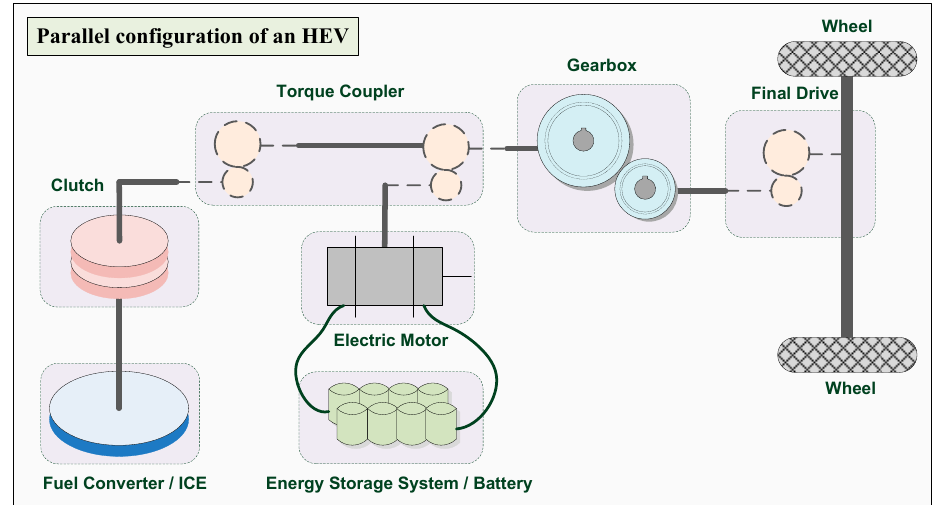
Figure 2. Parallel configuration of an HEV.